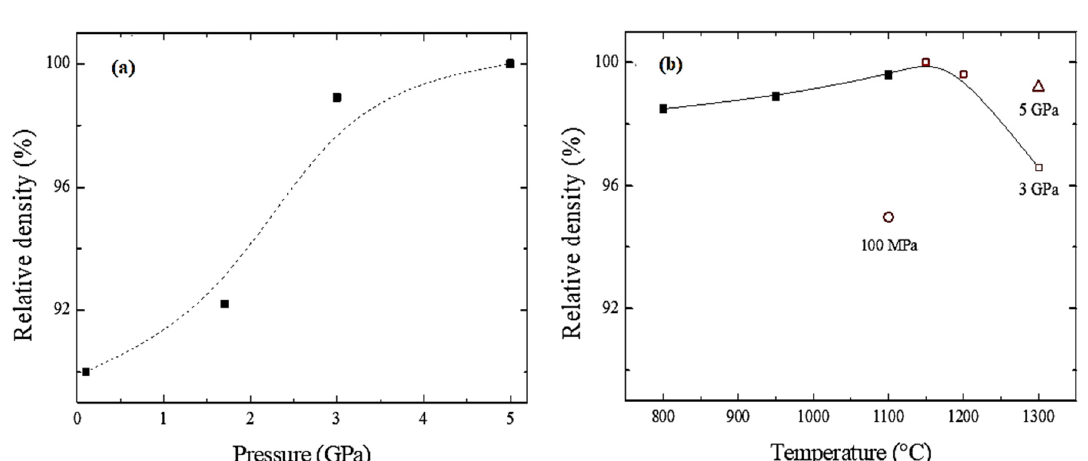
Figure 2. Density of MgB 2 with ( a ) Pressure at 950 °C and ( b ) Temperature at 3 GPa (red hollow symbols stand for decomposed samples).